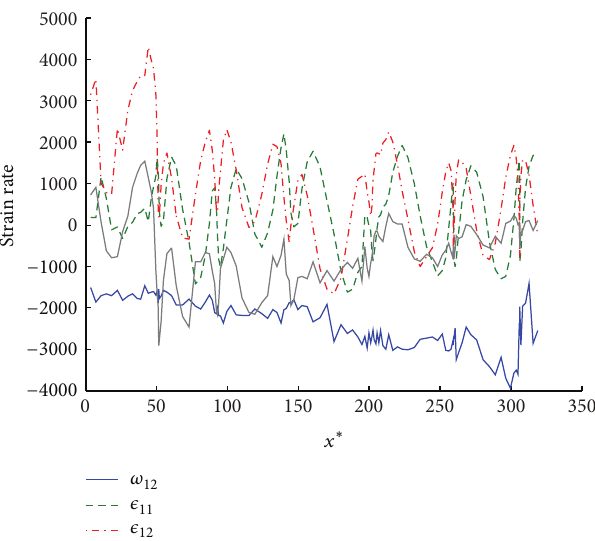
Figure 6: Profiles of the vorticity and deformation rate along a sam- ple Lagrangian trajectory. The continuous gray is the corresponding determinant Δ evaluated from (7).